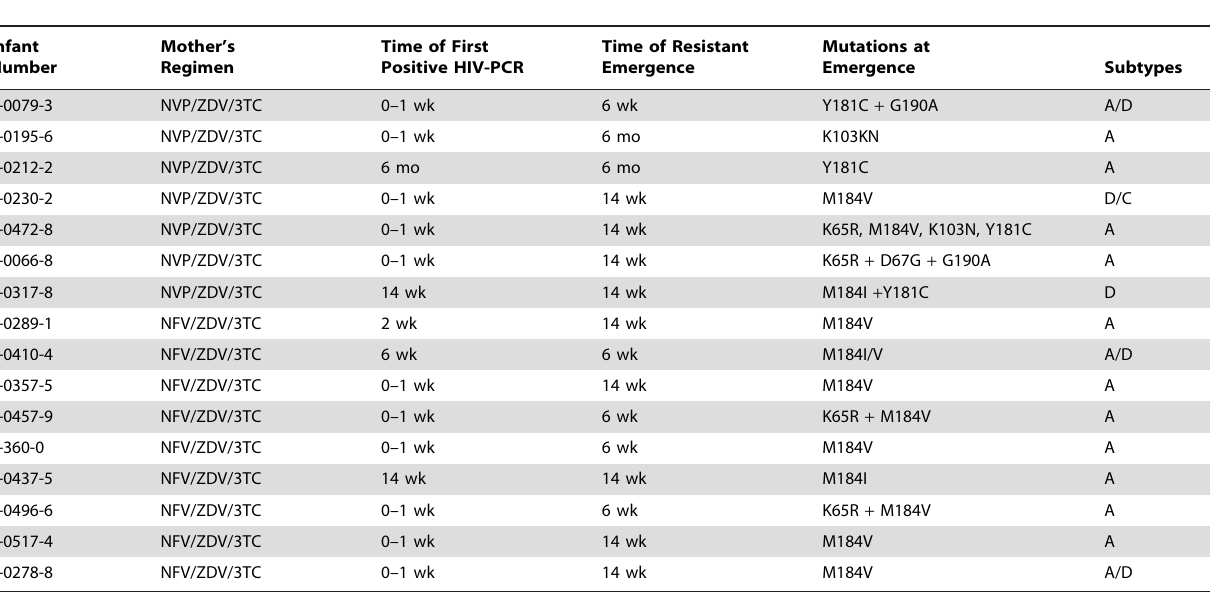
Table 3. HIV drug resistance mutation patterns among breastfeeding infants at time of